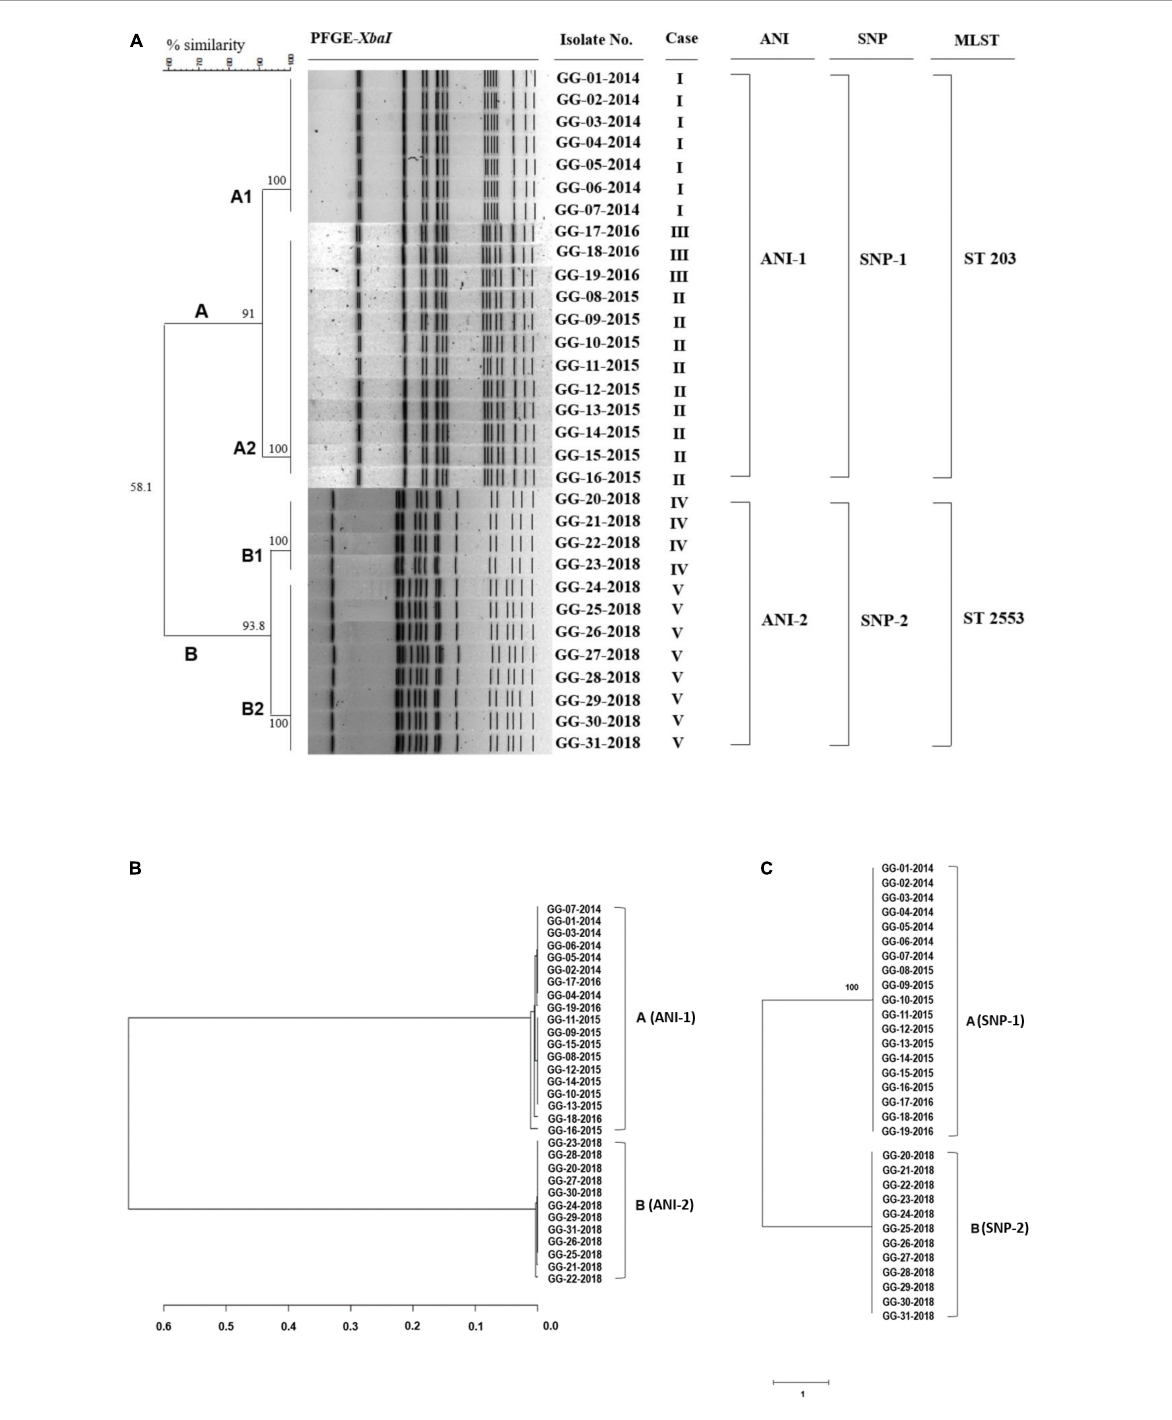
FIGURE1 PFGE analysis, ANI phylogenetic tree, and SNP phylogenetic tree of 31 S . Bareilly clinical isolates from food-borne disease in South Korea. (A) Dendrogram of the PFGE- Xba I fragment pattern. Similarity (%) between patterns was calculated from the Dice index and is represented by the number beside the node. In silico multilocus sequence typing (MLST) analysis using seven gene sequences: aroC , dnaN , hemD , hisD , purE , sucA , and thrA showed two different groups of 31 S. Bareilly isolates, ST 203 and ST 2553. (B) The ANI phylogenetic tree of S . Bareilly. The evolutionary relatedness between S . Bareilly species were measured using the average nucleotide identity values. The average nucleotide identity (ANI) values were calculated using JSpecies by comparing whole genome sequences of S . Bareilly, which were fragmented into 1,020 bp, based on BLAST algorithm. The trees were constructed using R programming. (C) The SNP phylogenetic tree was analyzed using the neighbor joining method. Visualization of the tree was conducted using FigTree software (see Section “Materials and